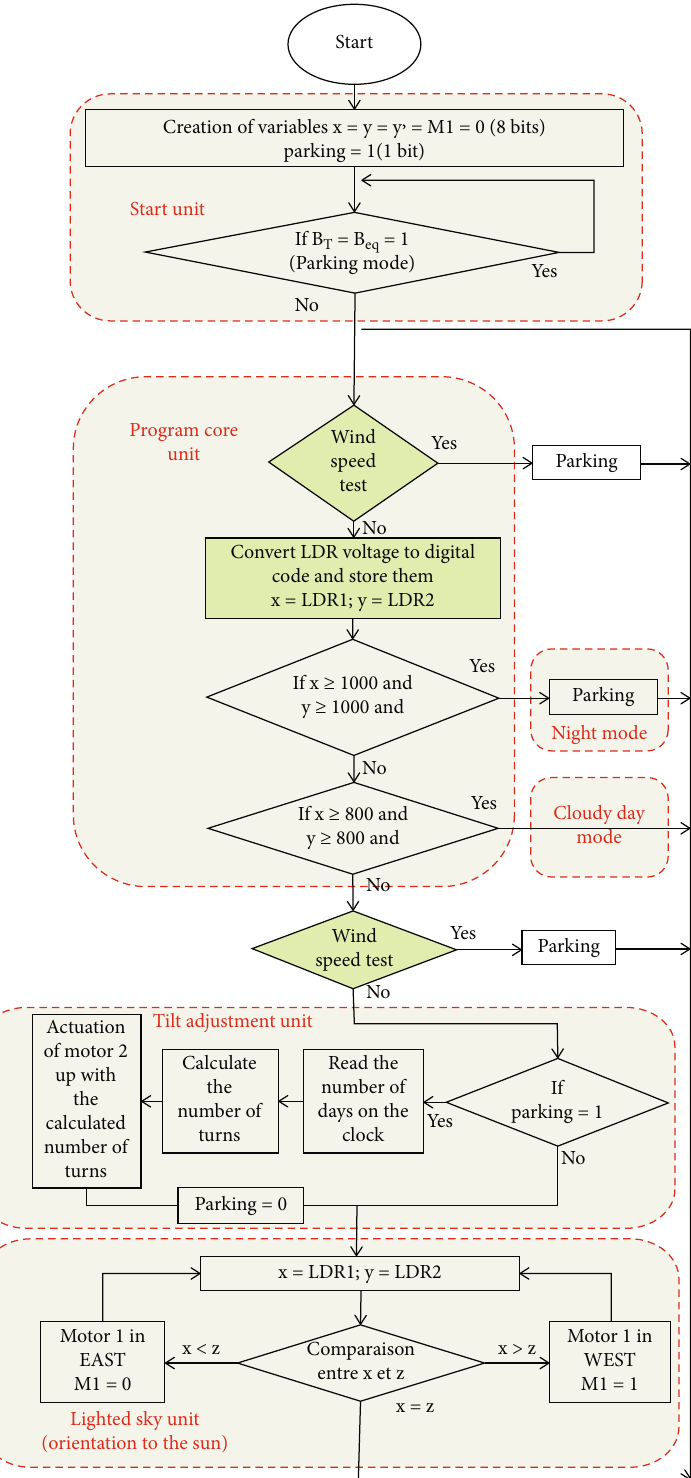
Figure 40: The principal fl